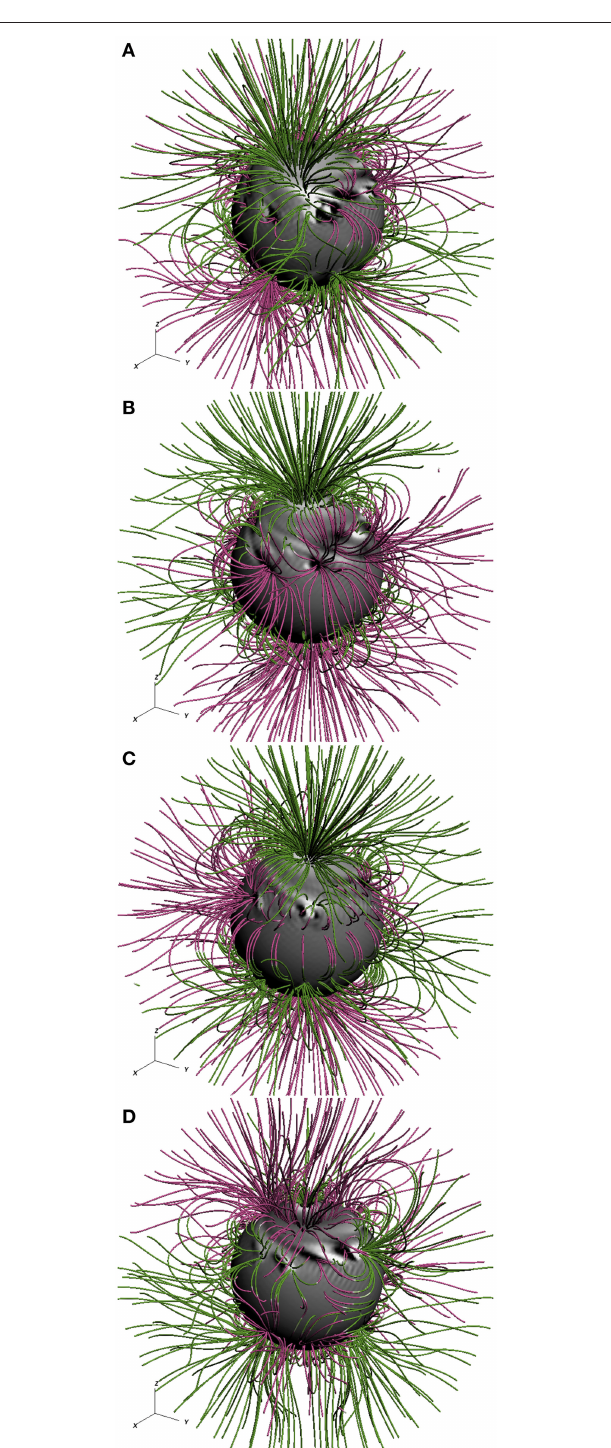
FIGURE 7 | Magnetic field lines at the solar surface at the rise phase of the fifth cycle, at the reversal of the polar field, at sunspot minimum, and immediately after the polarity reversal (as in the previous figures). The surface B r is rendered in gray scale (white for positive and black for negative polarities). The lines are magnetic field lines extrapolated from the surface using PFSS, with source-surface radius at 2.5 R ⊙ . Green and violet colors correspond to positive and negative B r .